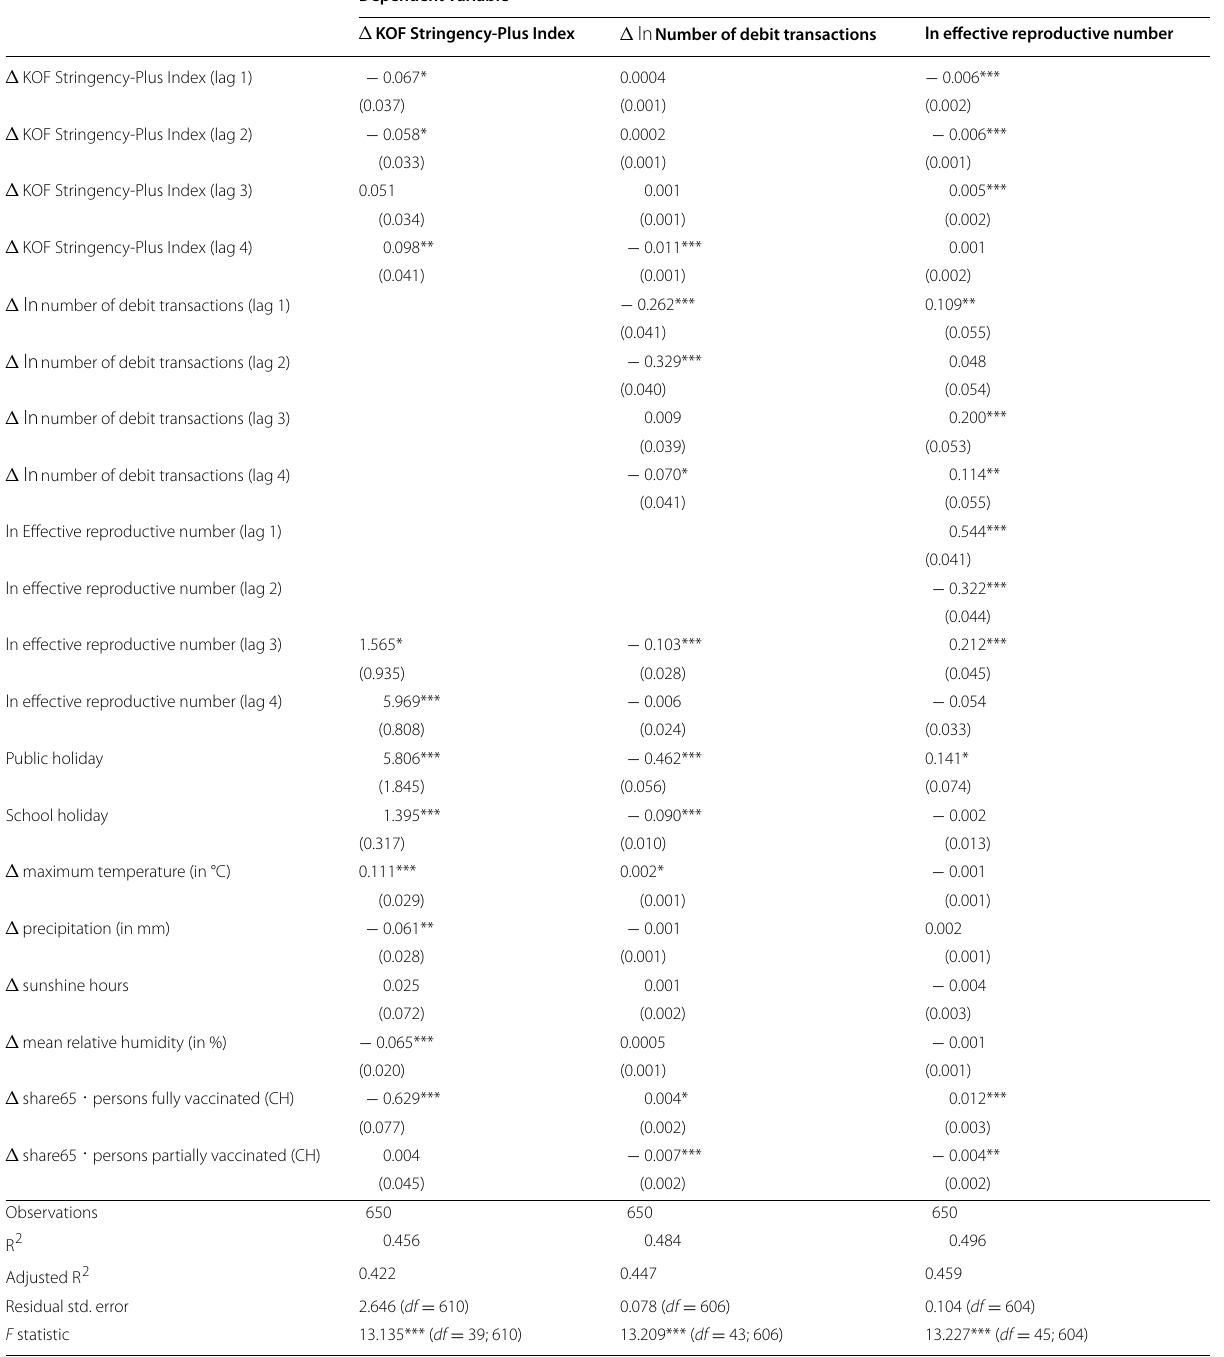
Table 2 VAR(3) with canton fixed